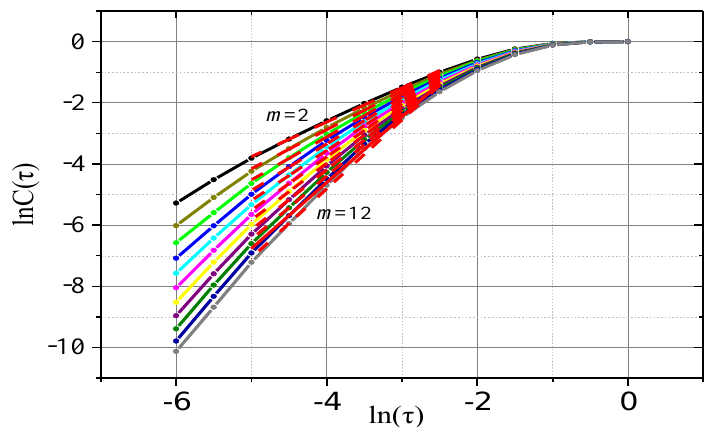
Figure 7. Relation curve between ln C ( τ ) and ln ( τ ) for the triangular target.